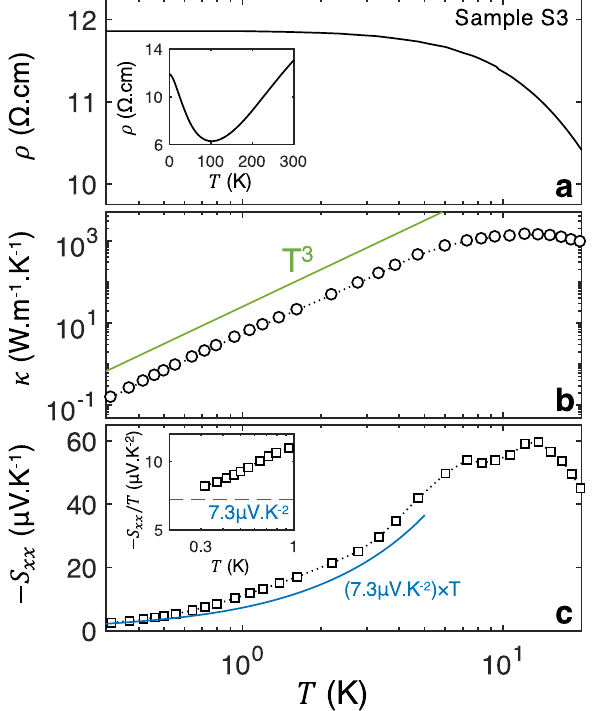
Fig. 1 Transport properties of n-type InAs at B = 0T. a Resistivity Fig. 2 Metal – Insulator transition in InAs. a Transverse ( j ( ρ ), b thermal conductivity ( κ ), and c − S xx of InAs sample S3 as magnetoresistivity of sample S1 for various temperatures up to functions of the temperature at B = 0T (see Supplementary Note 1). B = 35 T. The evolution of the Hall carrier concentration n H with the Inset in a shows ρ up to T = 300 K. The solid green line in magnetic fi eld, for the same sample and temperatures, is featured in b represents a T 3 power law characteristic of phonon contribution in b alongside the electronic mobility μ in c . Inset of b shows the Hall plotted as a function the ballistic regime. The inset in c shows (cid:3) S xx T resistivity of the sample. The vertical dotted line marks the quantum of the temperature in the sub-Kelvin region. The blue dashed limit at B QL . d Sketch of the magnetic freeze-out effect: as the ¼ 7 : 3 µV K − 2 , which is expected in line corresponds to the value S xx T magnetic fi eld increases the effective Bohr radius a (cid:4) the diffusive regime of a degenerate electron gas with T F = 100 K (see Supplementary Note 3). The diffusive contribution is further emphasized as a blue line in c ).